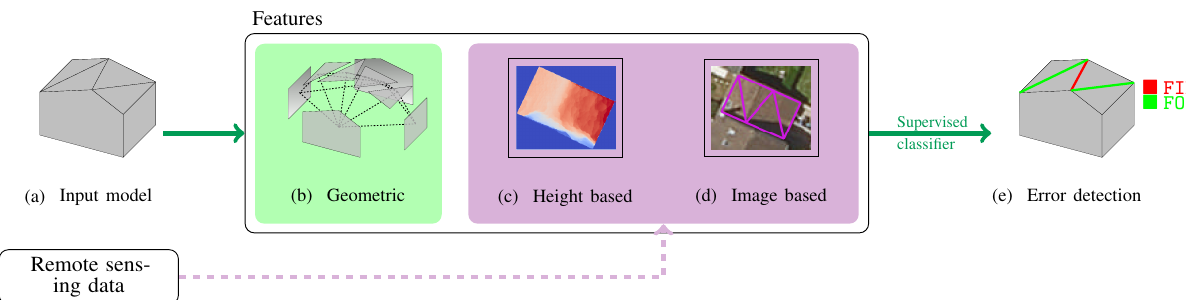
Figure 2. Quality evaluation workflow presented in (Ennafii et al., 2019) for 3D building models. Both intrinsic attributes (Figure 2b) and external modalities (Figures 2c and 2d) are used to describe the input model (Figure 2a). Based on these features, a trained classifier predicts the presence of each error label (Figure